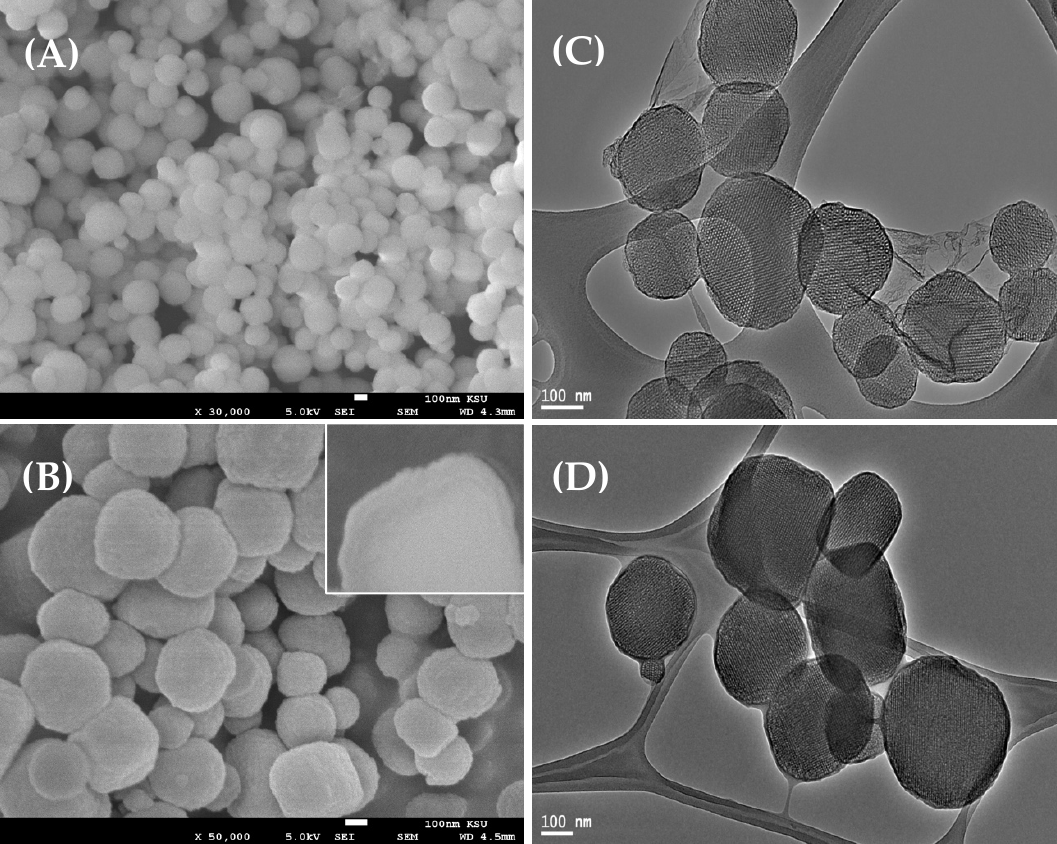
Figure 1. SEM and TEM images of fabricated mesoporous silica nanoparticles: ( A ) SEM image of unmodified MSNs, ( B ) SEM image of PDEAEMA-attached MSNs, ( C ) TEM image of as-made silica nanoparticles, and ( D ) TEM image of PDEAEMA-coated silica nanoparticles.